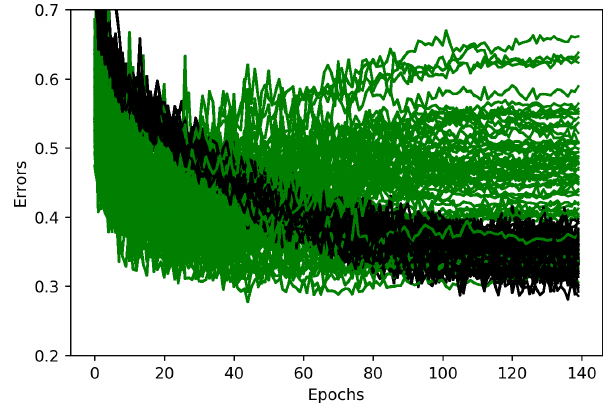
Figure 8. Train and validation errors over epochs for an LSTM model showing overfitting after 40